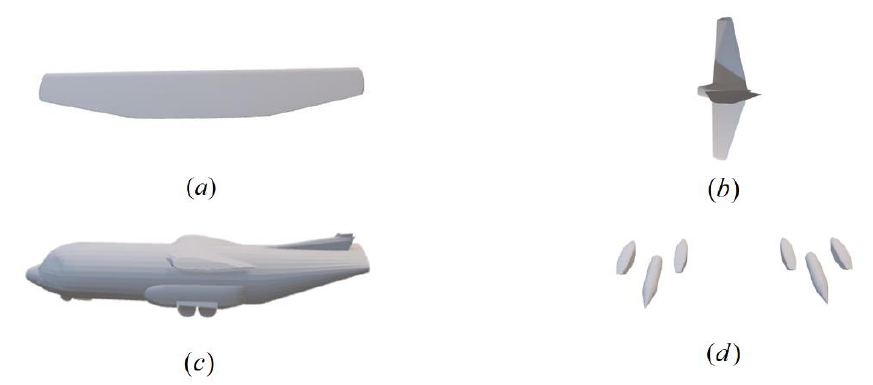
Figure 17. Airplane material: ( a ) airfoil (nickel titanium); ( b ) air-tail (special steel); ( c ) airframe (Inconel); ( d ) air-engine (copper nickel).